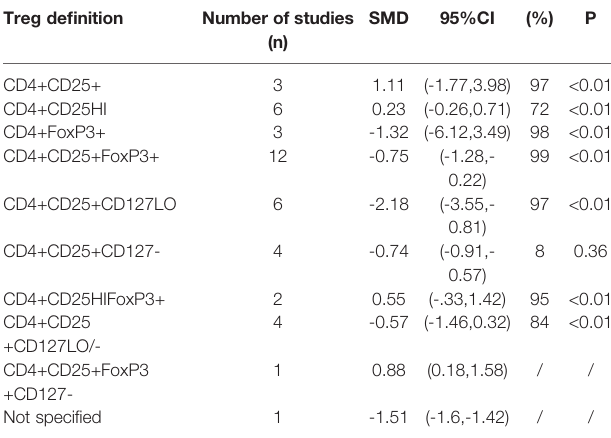
TABLE 3 | Subgroup analysis of Tregs proportions based on markers.